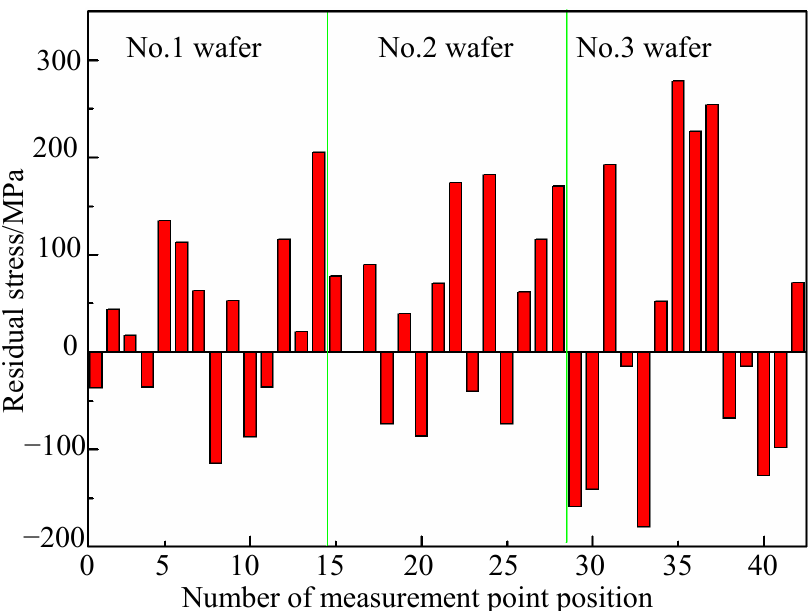
Figure 10. The residual stress of three silicon wafers. In Figure 10, the negative value indicates the residual stress is tensile stress. Conversely, the positive value is compressive stress. It can be seen that the residual tensile stress is between 0 and 200 MPa, while the compressive stress is between 0 and 300 MPa for the experimental results of this paper. In addition, the number of points demonstrating residual compressive stress is a little larger than those demonstrating residual tensile stress, the numbers of which are 24 and 18 respectively. The average tensile stress is smaller than the average compressive